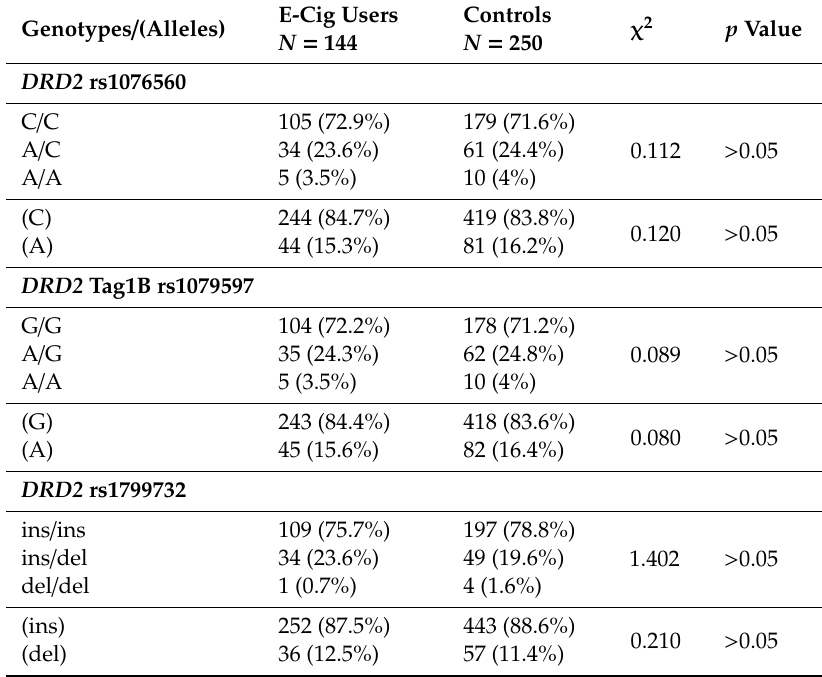
Table 1. Frequency of genotypes and alleles of the DRD2 rs1076560, rs1079597 and rs1799732 polymorphisms in e-cigarette users and controls.